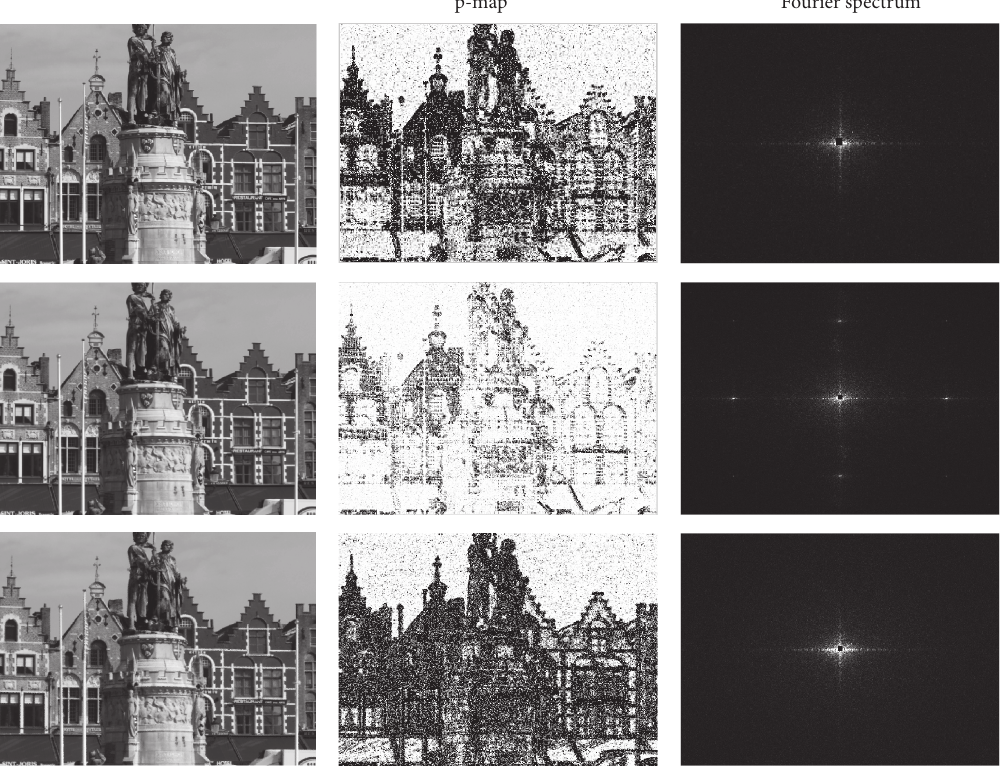
Figure 2: Top row: unaltered image, p-map, and its Fourier spectrum. Second row: upscaled image ( 𝑠 = 3/2 , bilinear). Third row: forged upscaled image ( attack 1, 𝑠 = 3/2 , bilinear, 𝜎 = 0.4